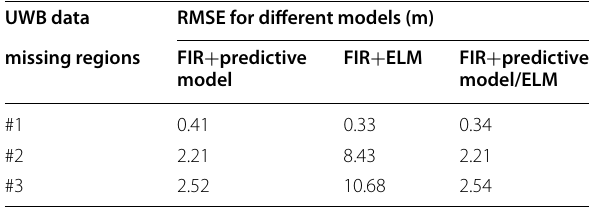
Fig. 10 The CDF of the localization errors measured by the FIR ▸ FIR predictive mode, and the FIR + data missing regions: a #1 UWB data missing region, b #2 UWB data missing region, c #3 UWB data missing region